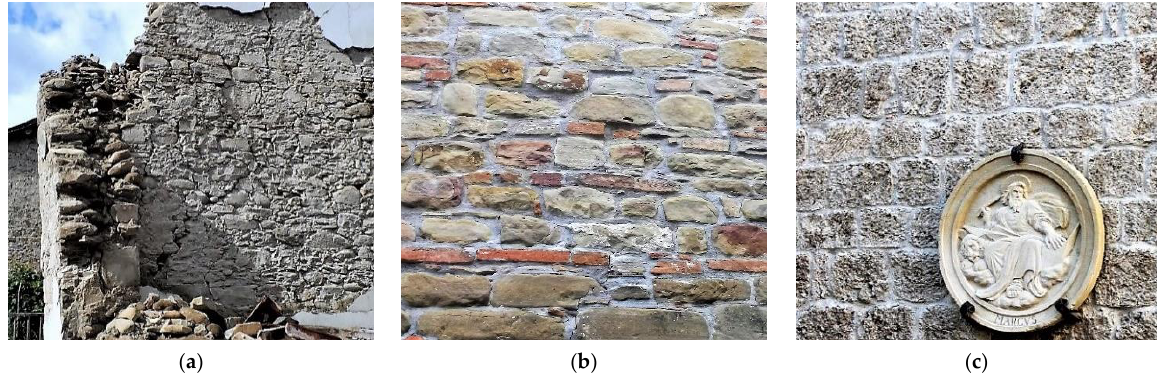
Figure 6. Different masonry typologies surveyed: ( a ) typical double-layer wall without headers (St. Francis, Amatrice); ( b ) irregular rubble masonry with partially staggered vertical joints (St. Savino in Gualdo, Macerata); ( c ) calcareous squared stones masonry (Abbey of Holy Mary in Montesanto, Civitella del Tronto).